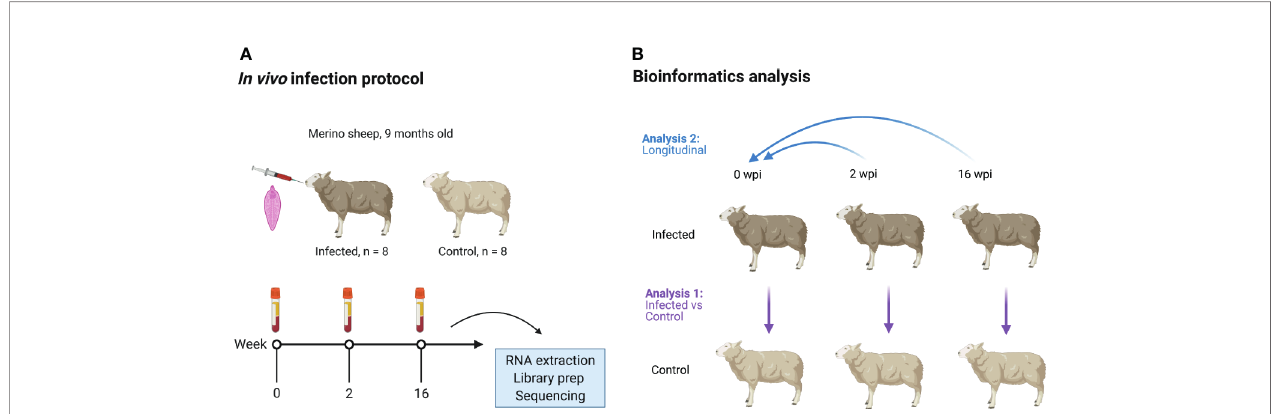
FIGURE 1 | Overview of the animal infection protocol (A) and bioinformatics analysis (B) . Sixteen male Merino-breed sheep were randomly assigned to an infected or control group and orally infected with a single dose of liver fl uke ( Fasciola hepatica ). Blood was then collected for isolation of peripheral blood mononuclear cells (PBMC). These cells were used to generate poly-A selected, stranded 2 x 150 bp RNA sequencing data on a NovaSeq 6000, at 0, 2 and 16 wpi. These data were then analysed for DE genes using two approaches: analysis 1 (infected vs control) - infected animals were compared to control animals at each time point; analysis 2 (longitudinal) - the infected and control animals were compared separately to their pre-infection time points. The DE gene lists of both groups were then compared, and the DE genes which occurred in the infected group but not in the control group at each time point were considered to be the potential DE genes in response to F. hepatica . wpi, weeks post-infection. Image created using